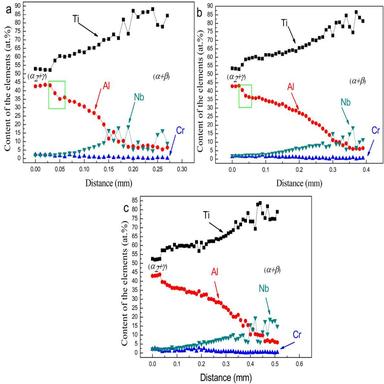
Line distribution of the elements of the ITZs of the 0.5, 1, and 2 mm overlap specimens: (a) 0.5 mm, (b) 1.0 mm and (c) 2.0 mm.